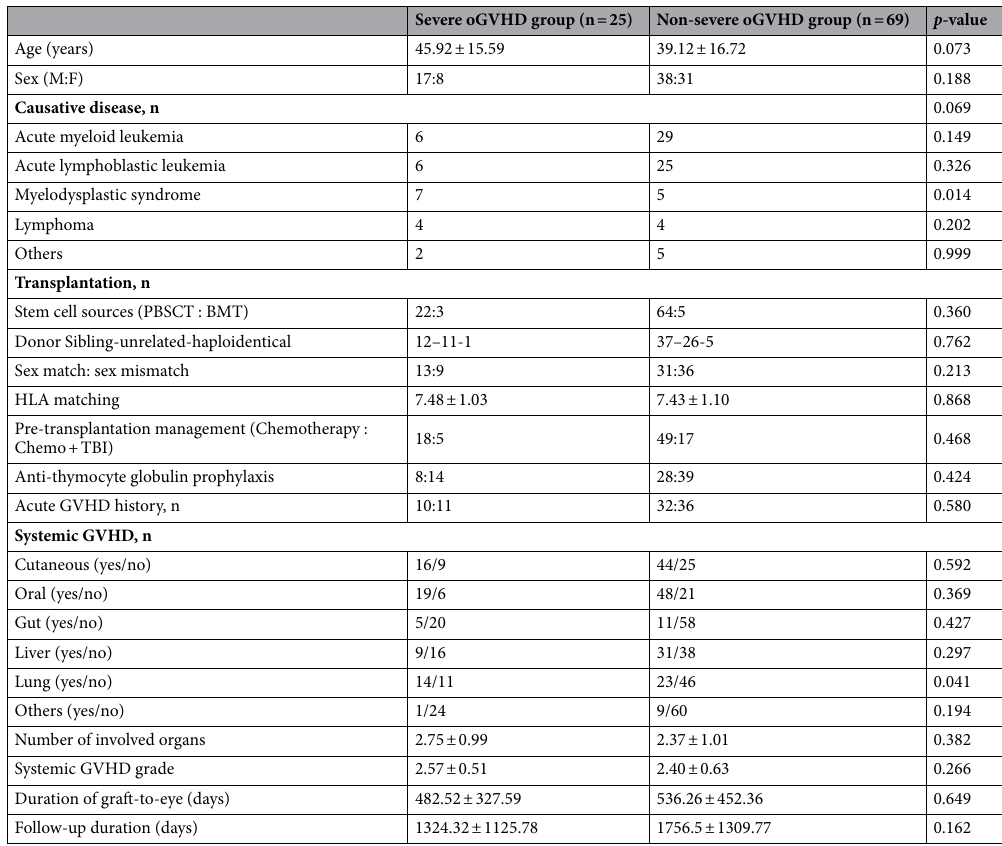
Table 2. Differences in systemic characteristics between the severe and non-severe graft-versus-host disease (GVHD) groups. PBSCT Peripheral blood stem cell transplantation, BMT Bone marrow transplantation, HLA Human leukocyte antigen, TBI Total body irradiation.